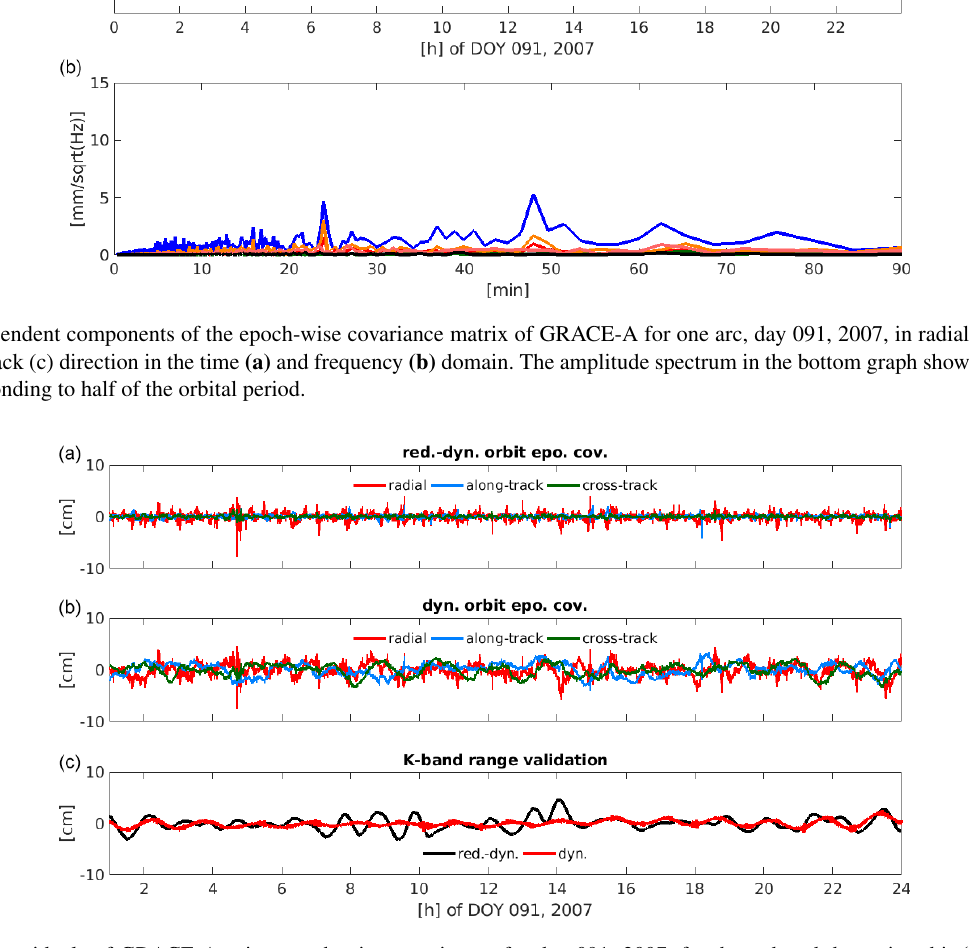
Figure 2. Orbit residuals of GRACE-A using epoch-wise covariances for day 091, 2007, for the reduced-dynamic orbit (a) , the dynamic orbit (b) , and the respective K-band range validations (c) .